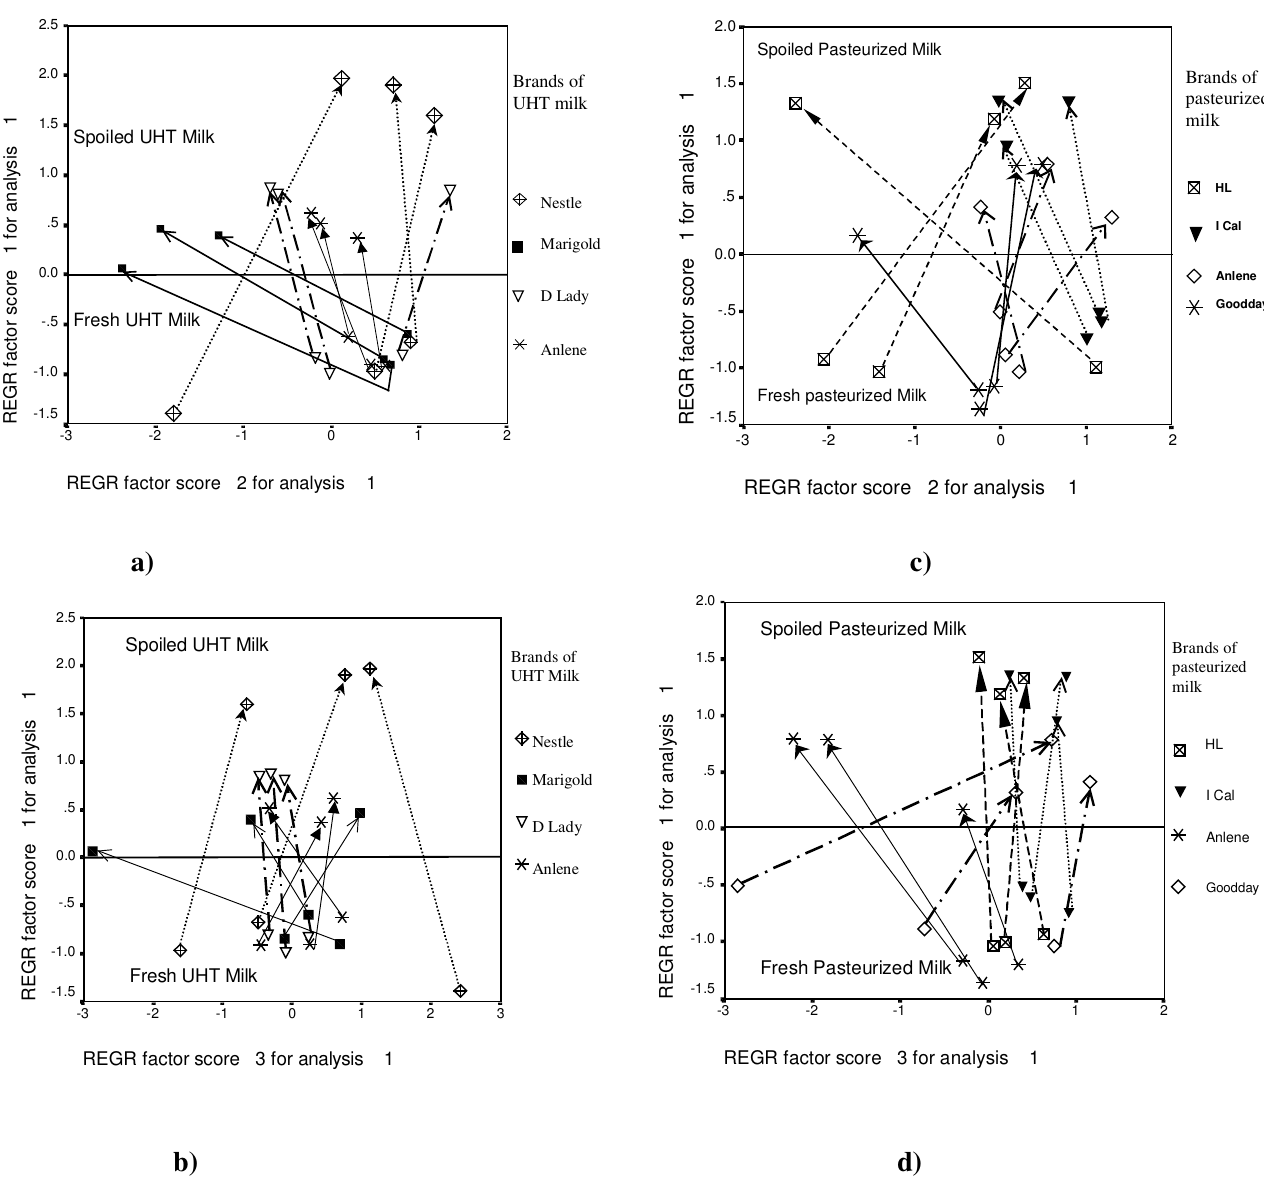
Figure 4. Discriminating abilities of the disposable ‘Taste Sensor’ system between fresh (0 hour) and spoiled (48 hours) milk (a)(b) UHT Milk and (c)(d) Pasteurized Milk The plots can be divided into three parts. With increasing storage time, the PCA plots extend from right lower corner through the middle and to the right upper corner of the plots in both the above figures. An interesting observation can be made: the position of the samples (although partly of them are overlap) follow a path that bend upwards with the time order. The ‘freshness maps’ reflect the deterioration process or evolution features of milk quality with time due to microbial growth. The system appeared to be able to distinguish different categories of the ageing process of milk. Rapid evolution of milk quality can be observed in the starting period of storage time due to the distance of the data points, which are quite far from the others. The second data range (6 th -26 th hour) is